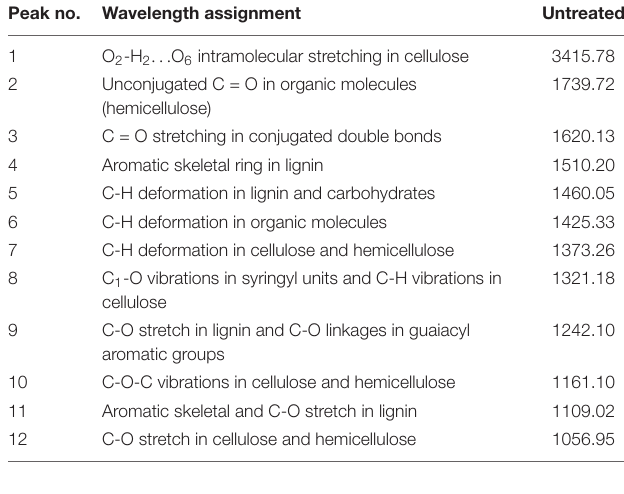
TABLE 1 | Fourier transform infrared spectroscopy (FTIR) absorption spectra obtained of the Salix psammophila sand barrier and their corresponding components.